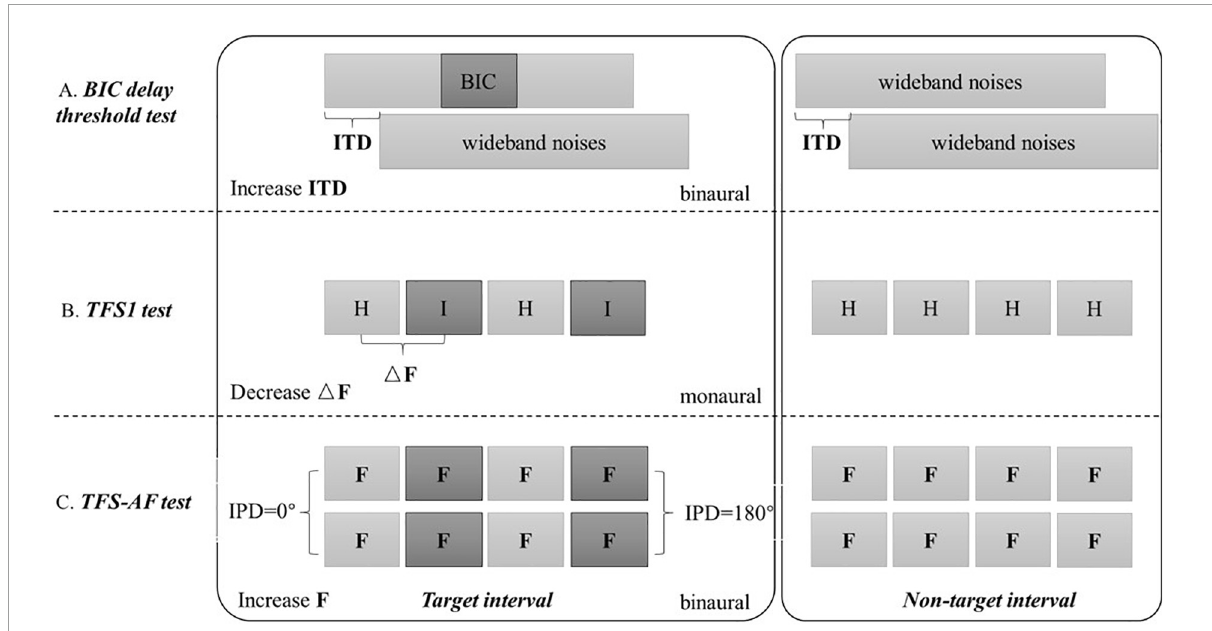
FIGURE1 Schematic diagram of three test methods. The BIC delay threshold test, TFS1 test, and TFS-AF test use the maximum ITD, minimum (cid:49) F/F0, and maximum F as thresholds,